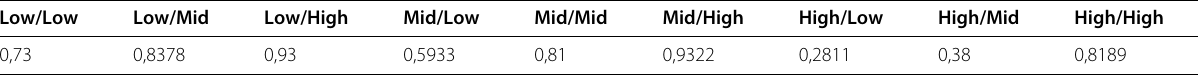
Table 6 Accuracy of proposed approach using RAISE full-size images compressed with custom table from Park et al. [35]